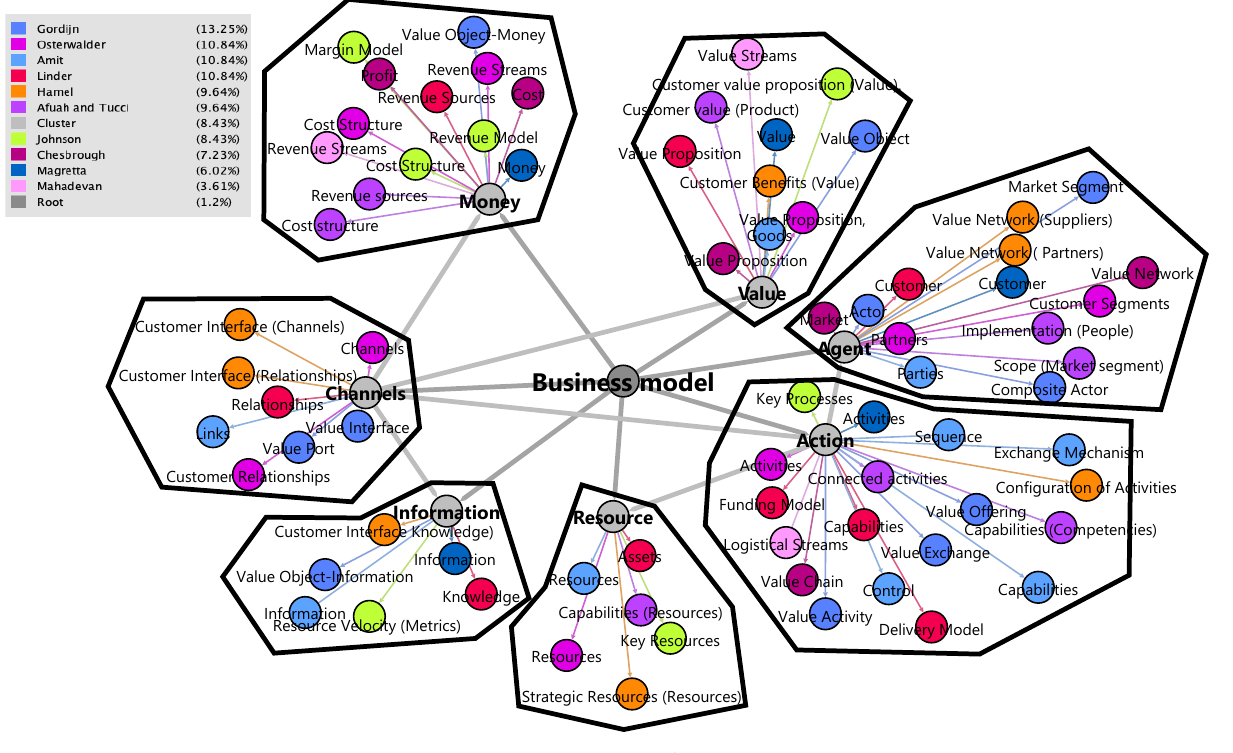
Figure 6. Concept